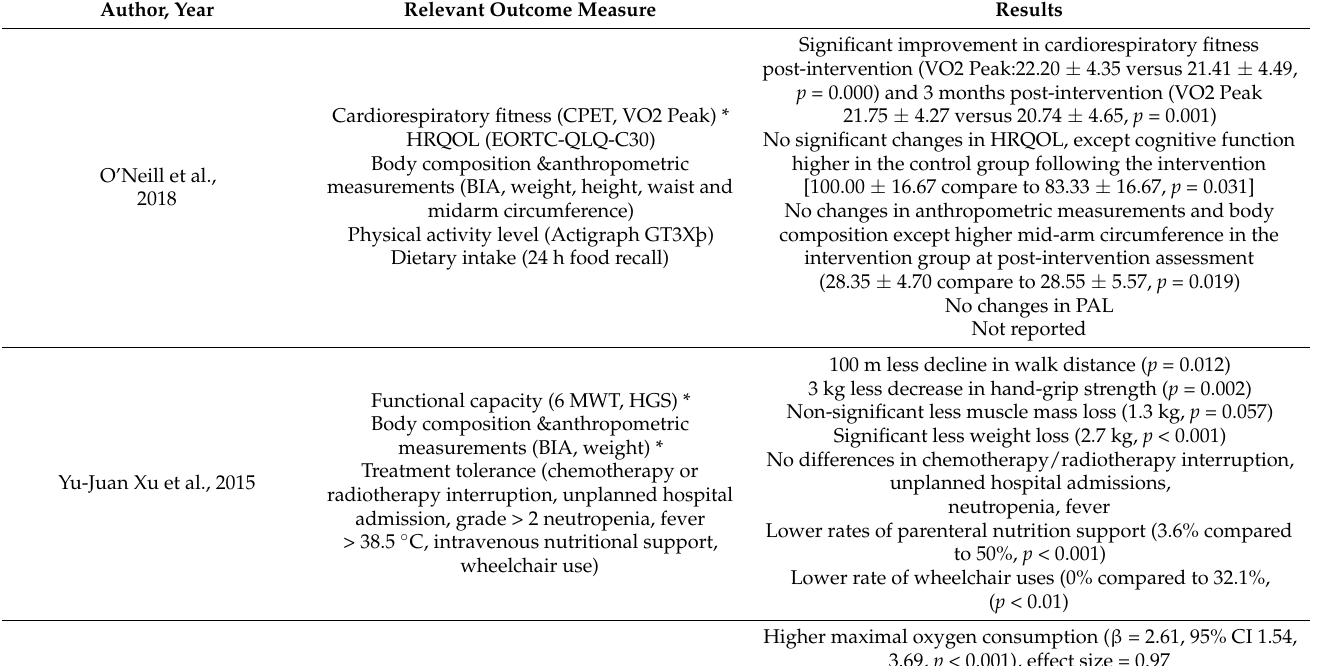
Table 3. Summary of